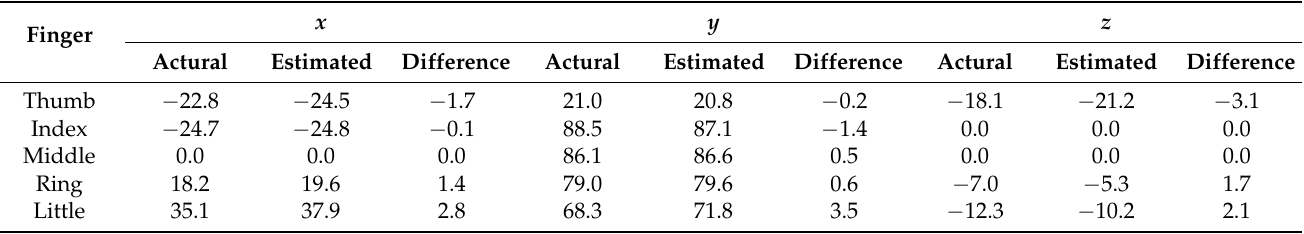
Table 5. Differences between the coordinates of the carpometacarpal (CMC) joint center of the thumb and the metacarpophalangeal (MCP) joint centers of the other four fingers estimated from the proposed regression models with the actural coordinates (unit: